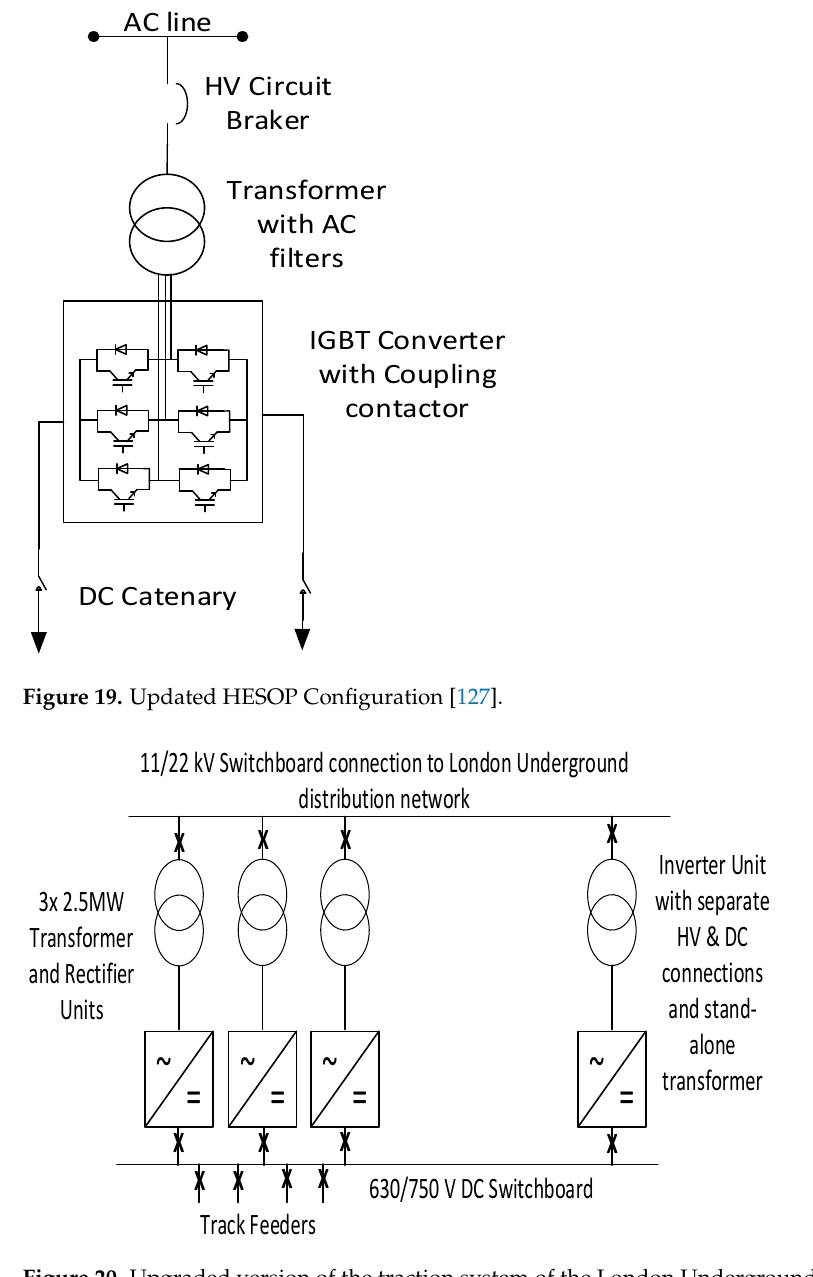
Figure 20. Upgraded version of the traction system of the London Underground [128].